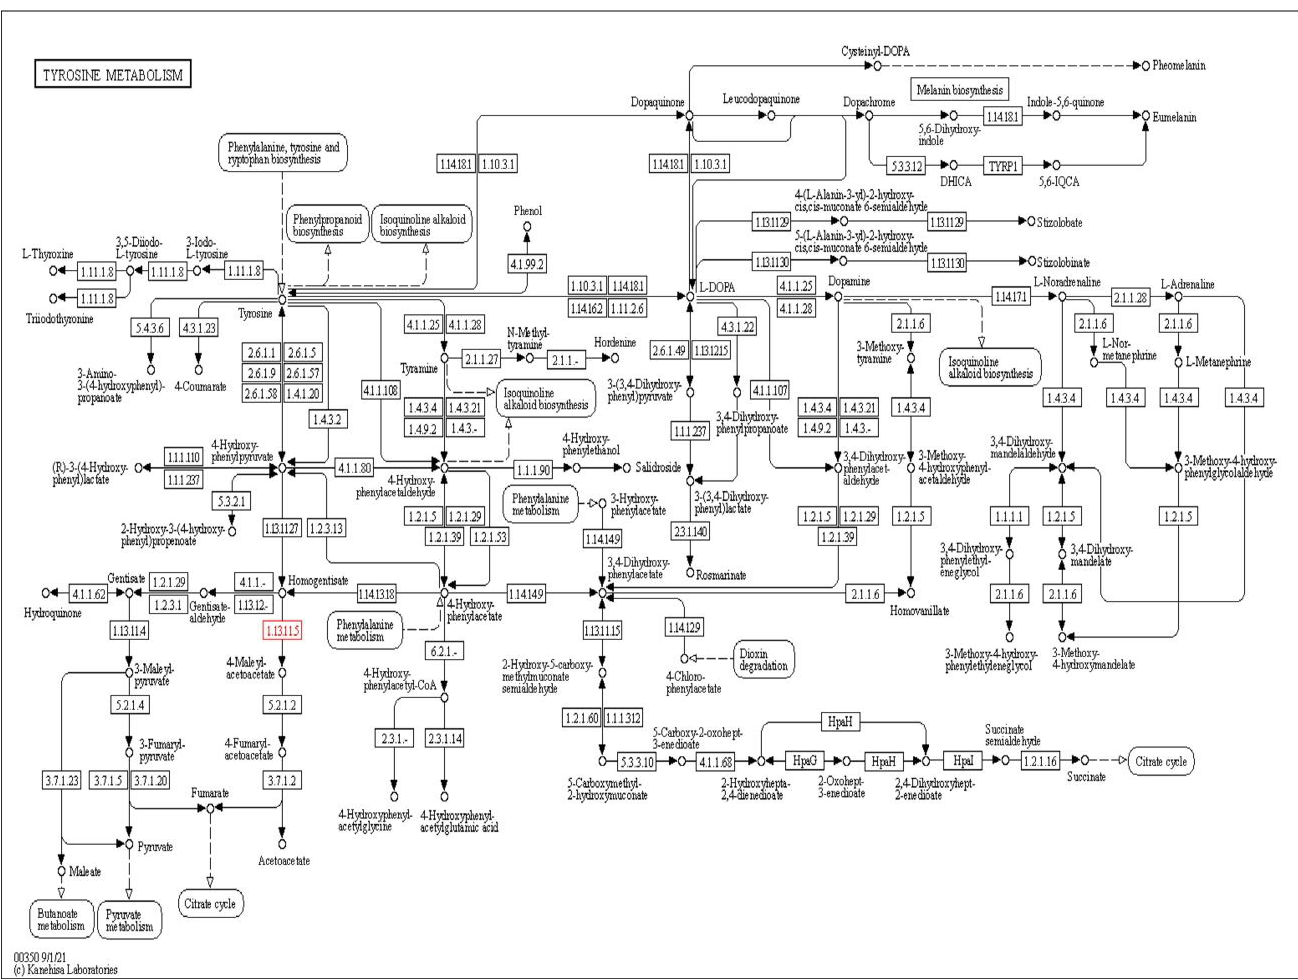
Figure 2. Tyrosine metabolism pathway by KEGG. The highlighted enzyme commission number (EC number) is representing the mutated enzyme in alkaptonuria.